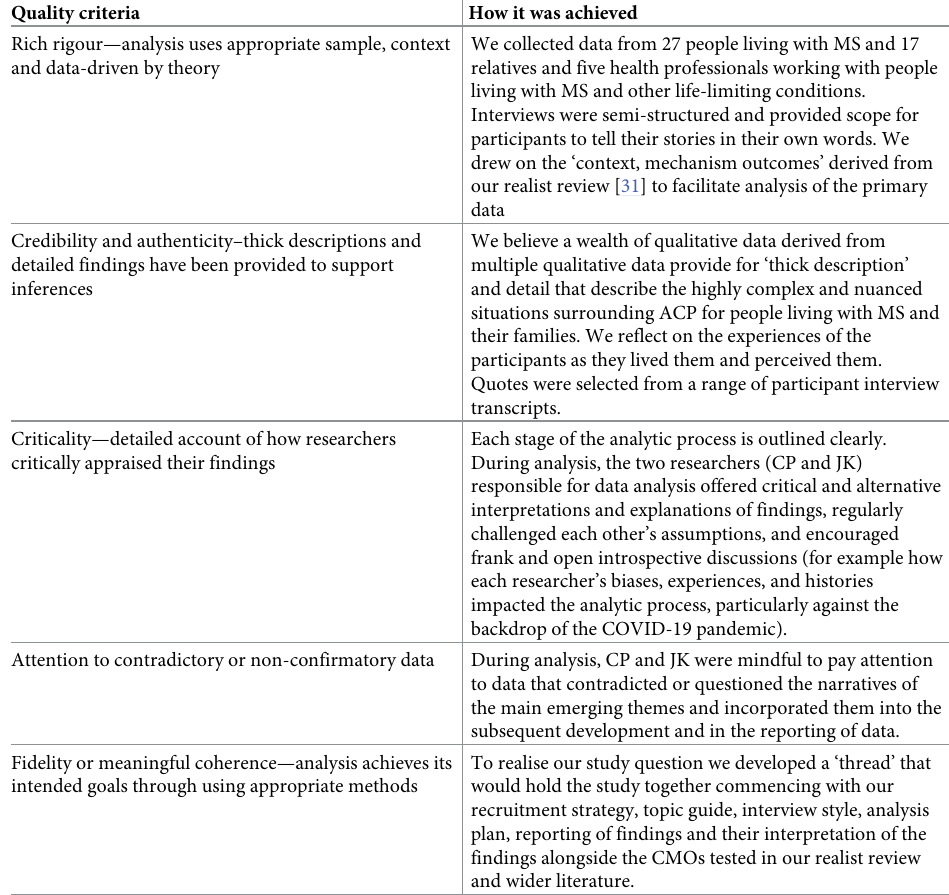
Table 2. Quality criteria selected for ensuring rigorous qualitative analysis [53,